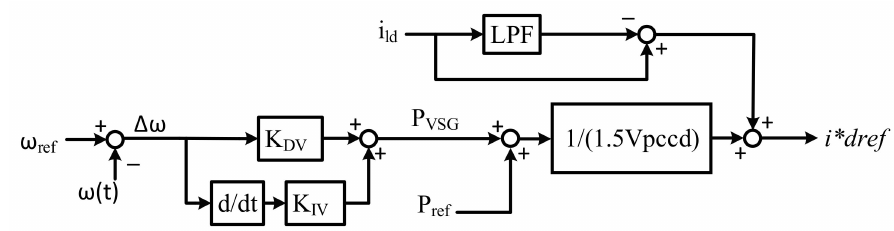
Figure 15. The proposed reference current generator block